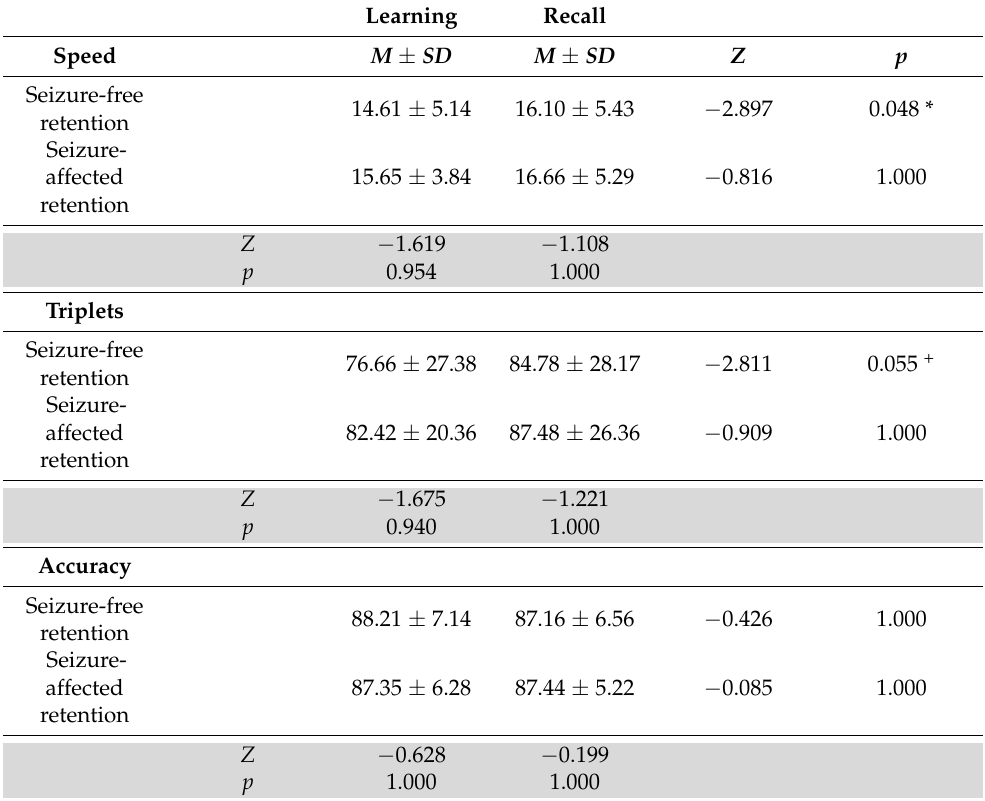
Table 2. Within-patient performance changes evaluated for retention periods based on the absence or presence of seizures ( n =